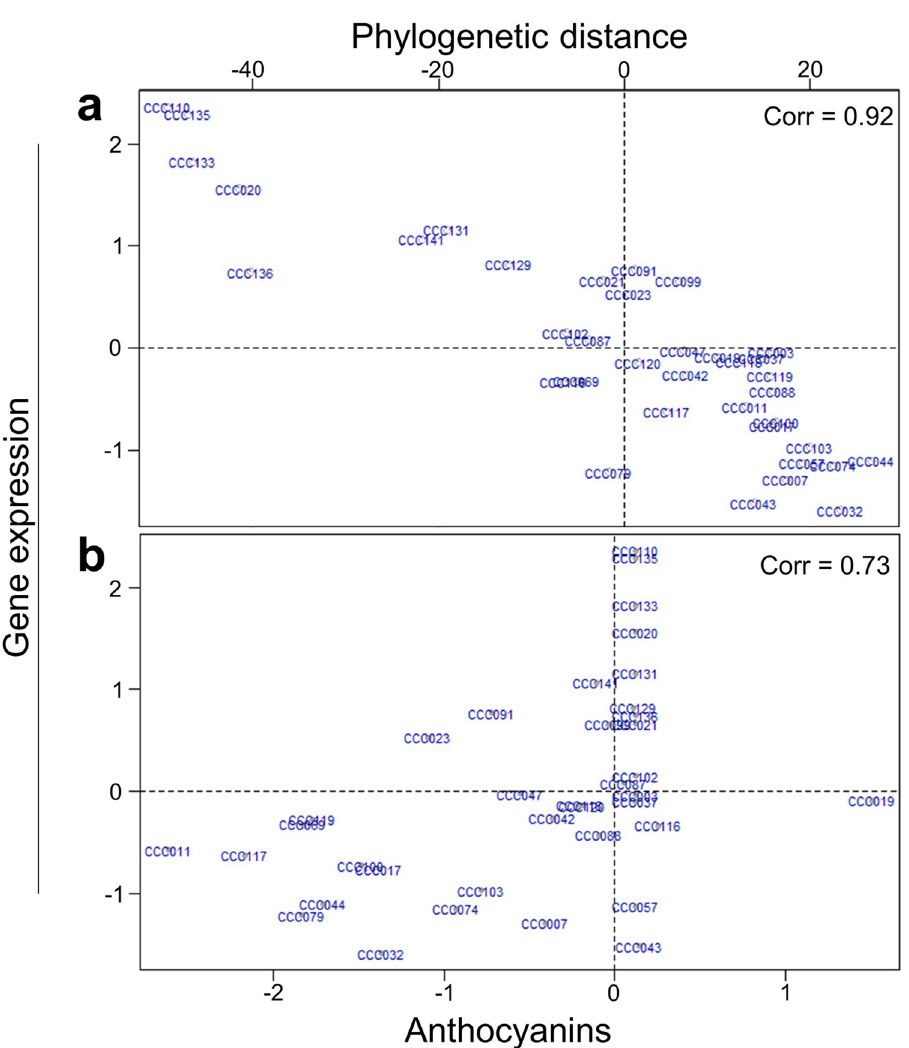
Fig 1. Results from Regularized and Sparse Generalized Canonical Correlation Analysis (RGCCA). The 37 potato accessions are plotted according to their RGCCA loadings for three sources of data used in our study: ( a ) global gene expression vs phylogenetic distance and ( b ) global gene expression vs anthocyanin content. Paired correlations between data sources are shown in shown in the top left.